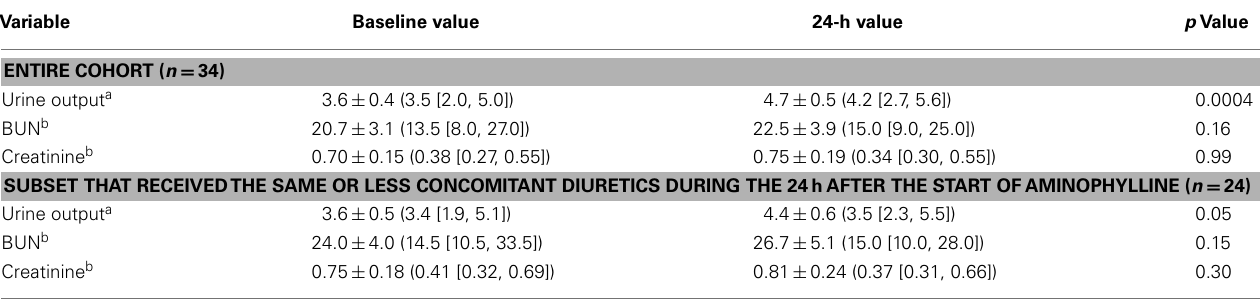
Table 2 |Assessment of renal variables before and after 24h of aminophylline .